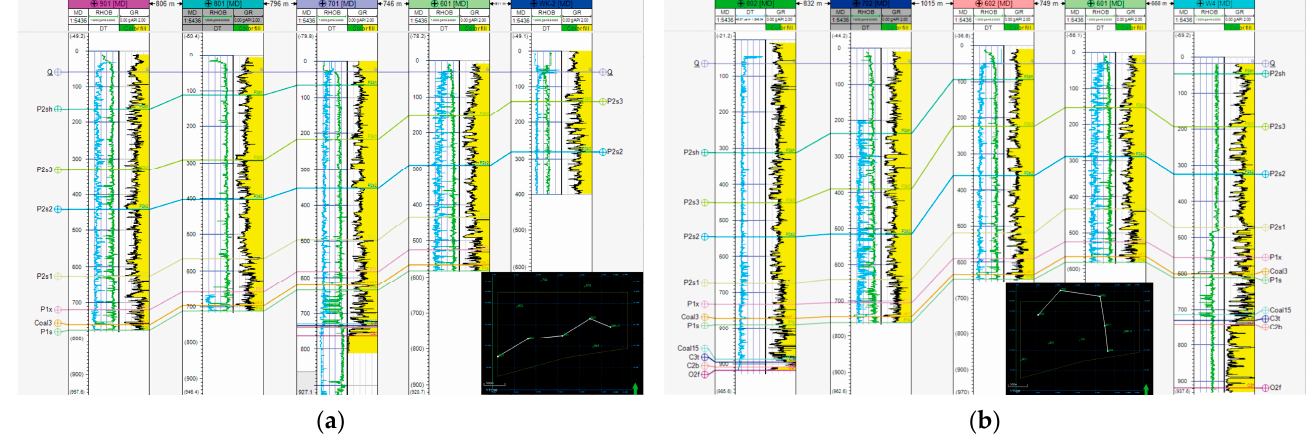
Figure 4. Well tie profiles: ( a ) 1-1 well tie profiles; ( b ) 1-2 well tie profiles.